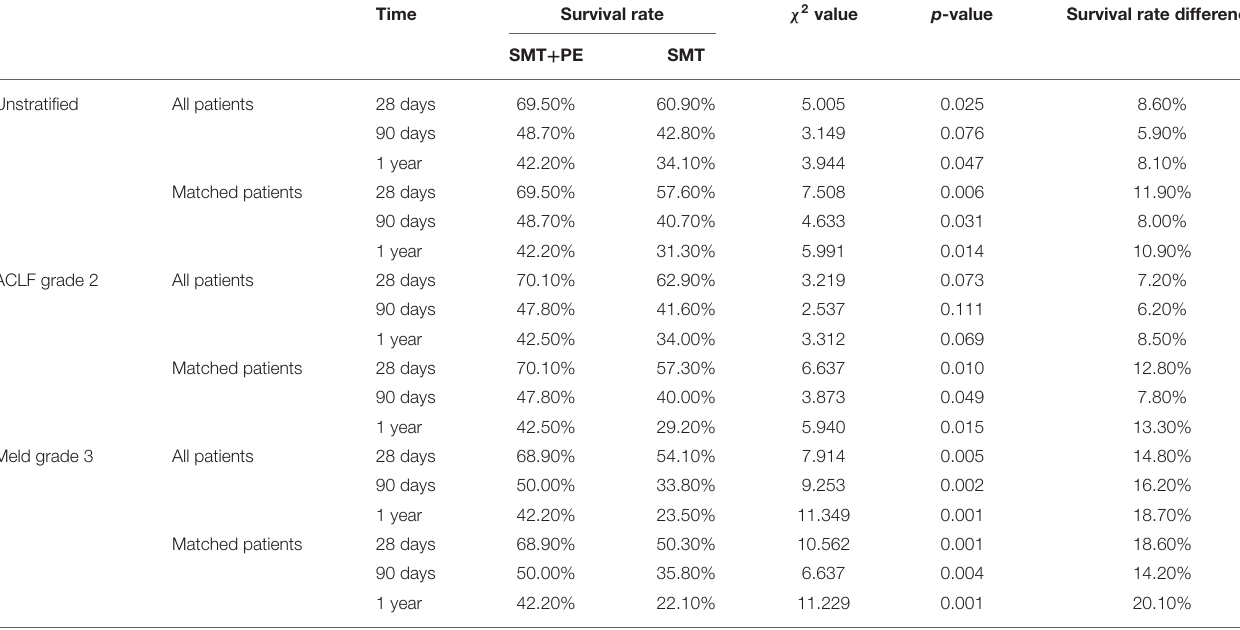
TABLE 2 | Cumulative survival rates of HBV-ACLF patients who received SMT alone or combination therapy with SMT and PE.